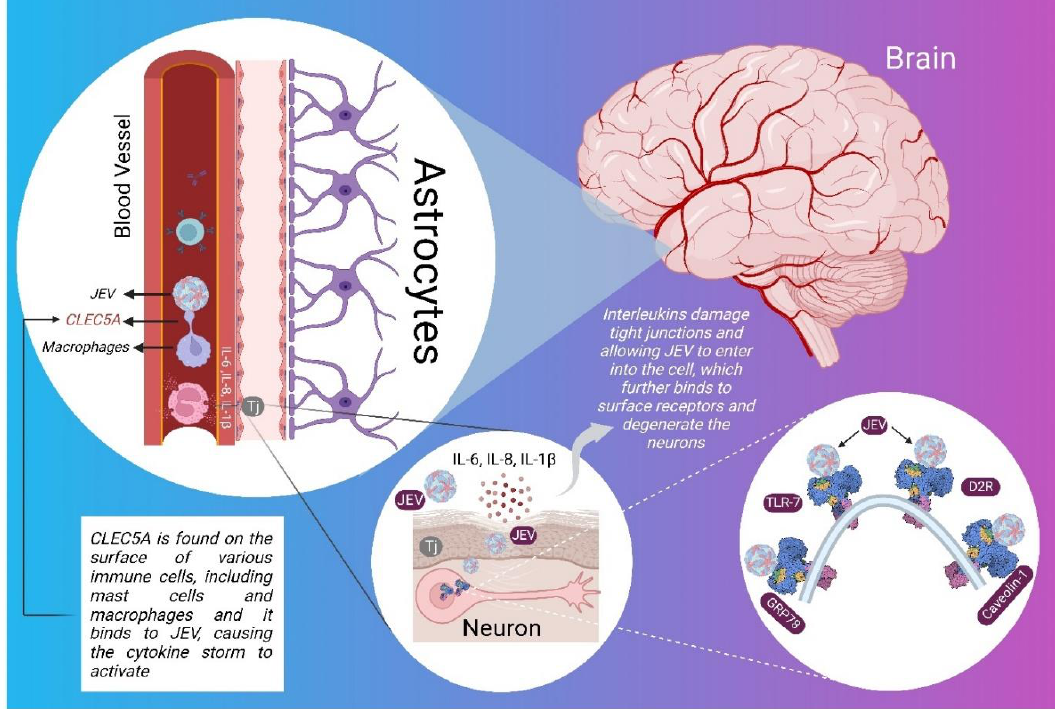
Figure 1. Interleukins (IL-6, Il-8, and IL-1) breakdown tight junction existing between endothelial cells of the blood-brain barrier of JEV-infected patients and target proteins present on the surface of ER of neurons and other surfaces of neurons, as shown in a systematic figure.